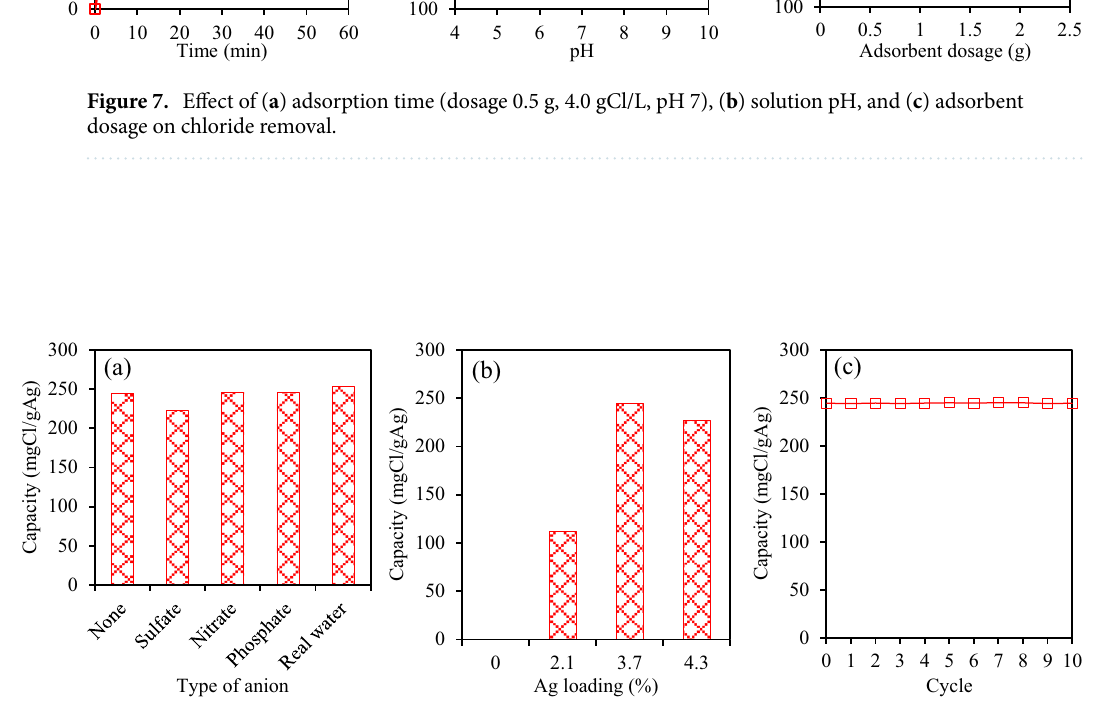
Figure 8. Chloride adsorption capacities under the effects of ( a ) other anions and ( b ) Ag loading and ( c ) stability for chloride removal of resin@P-Ag 2 O